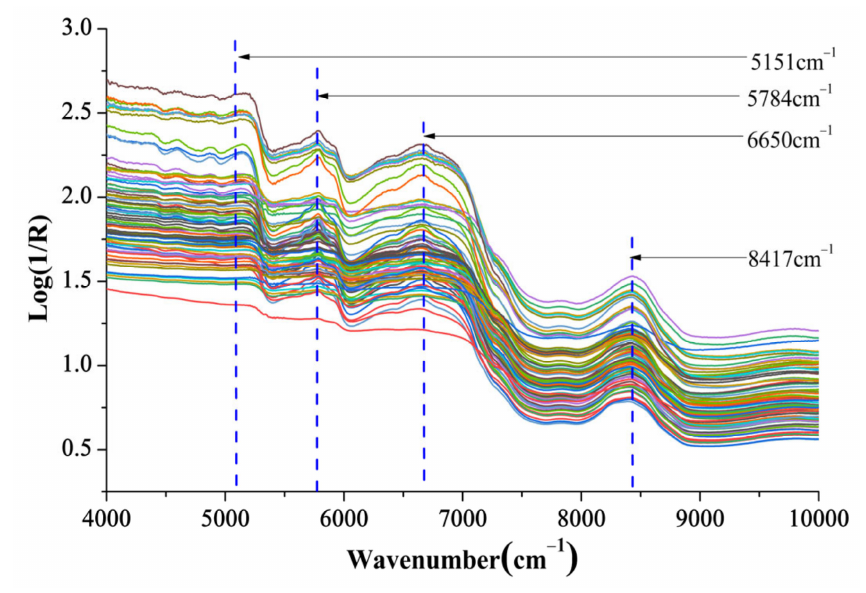
Figure 2. NIR spectra of Ejiao